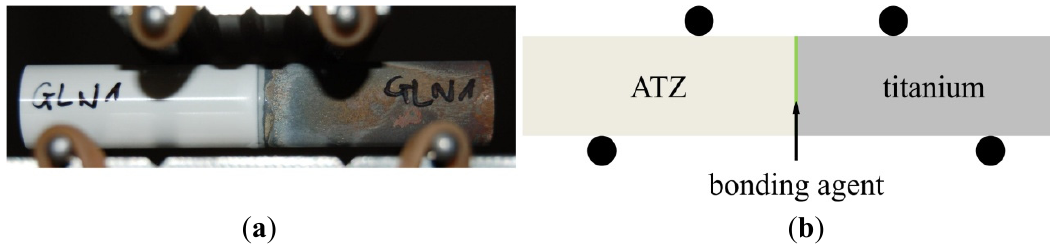
Figure 2. Four-point-bending test setup for a soldered compound sample ( a ); shown schematically ( b ); indicating supports on the bottom and loading noses on the top (black